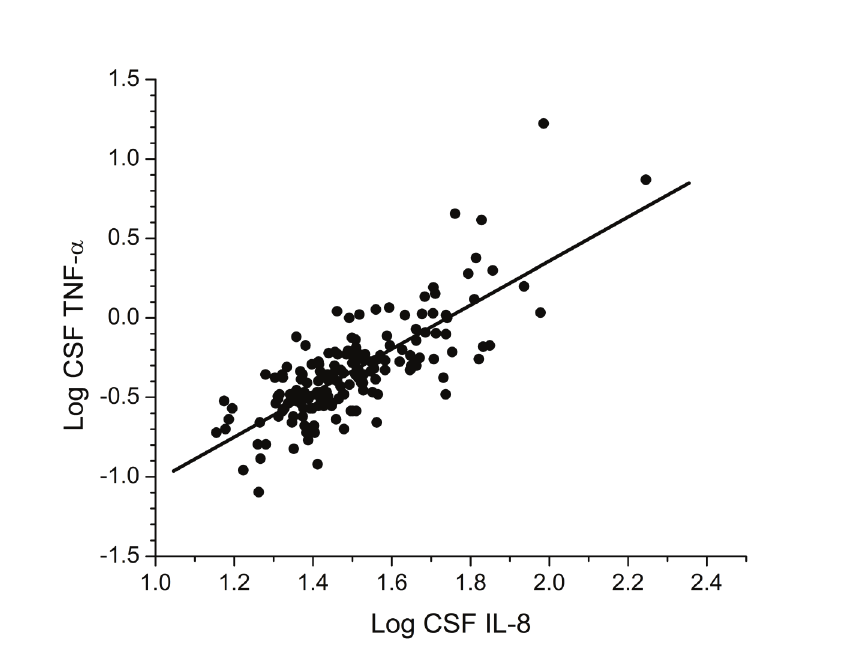
Figure 2. Comparison of log CSF IL-8 and log CSF TNF-α measurements in participants of European ancestry (R = 0.77; P <